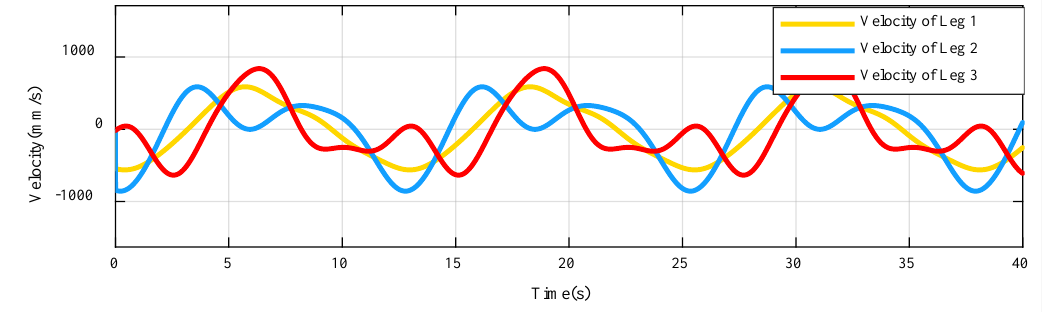
Figure 27. The velocity of support legs of the novel compensation platform during the compensation to the simulative wave.